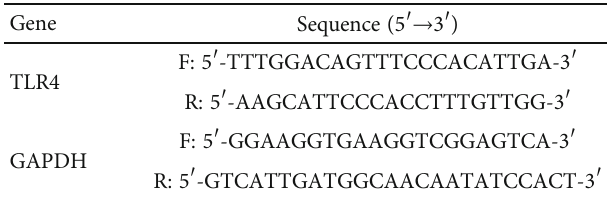
Table 1: Primer sequences used for q-PCR.